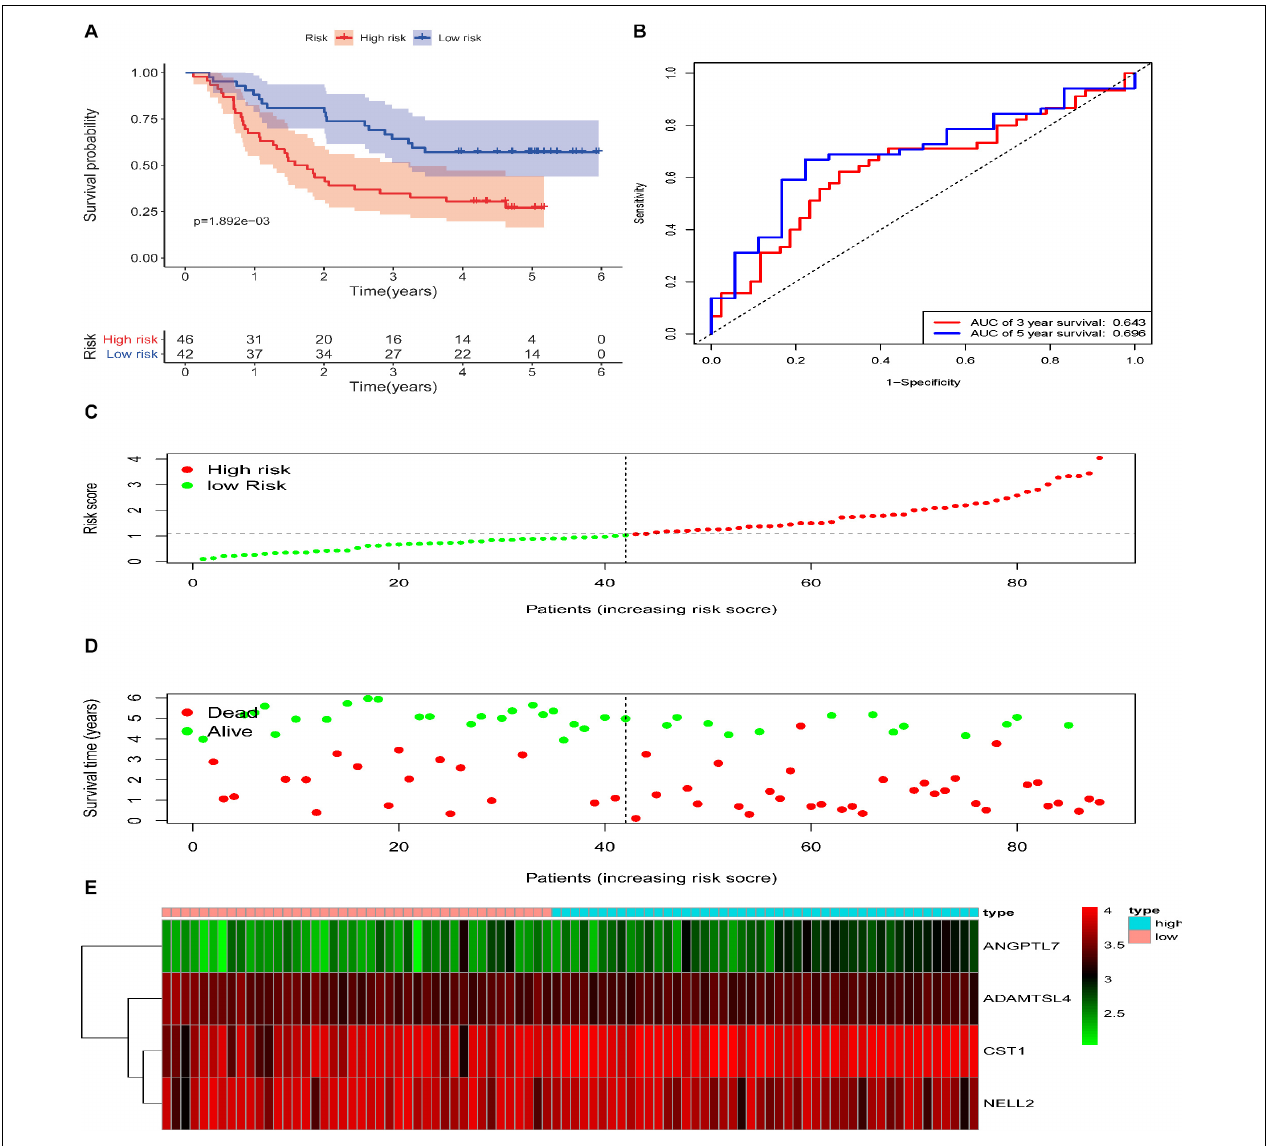
FIGURE 4 | Validation of the ECM–related signature in the testing cohort of patients with ESCC. (A) Kaplan-Meier survival curves of the relative overall survival of high- and low-risk patients. (B) ROC curve analysis of the prognostic signature. (C) Distribution of the four gene-based risk scores. (D) Vital statuses of patients in the high- and low-risk groups. (E) Heatmap of four-gene expression profiles in the high- and low-risk groups.